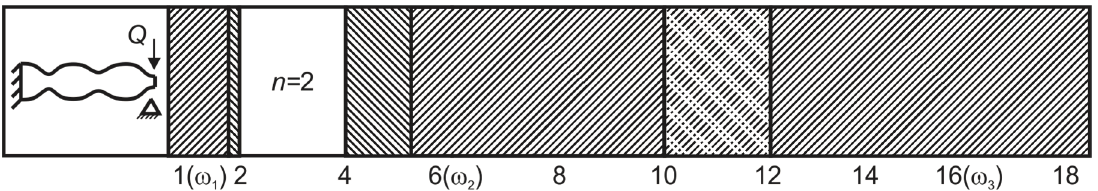
Figure 20. Periodically excited vibro-impact motion laws of the optimal